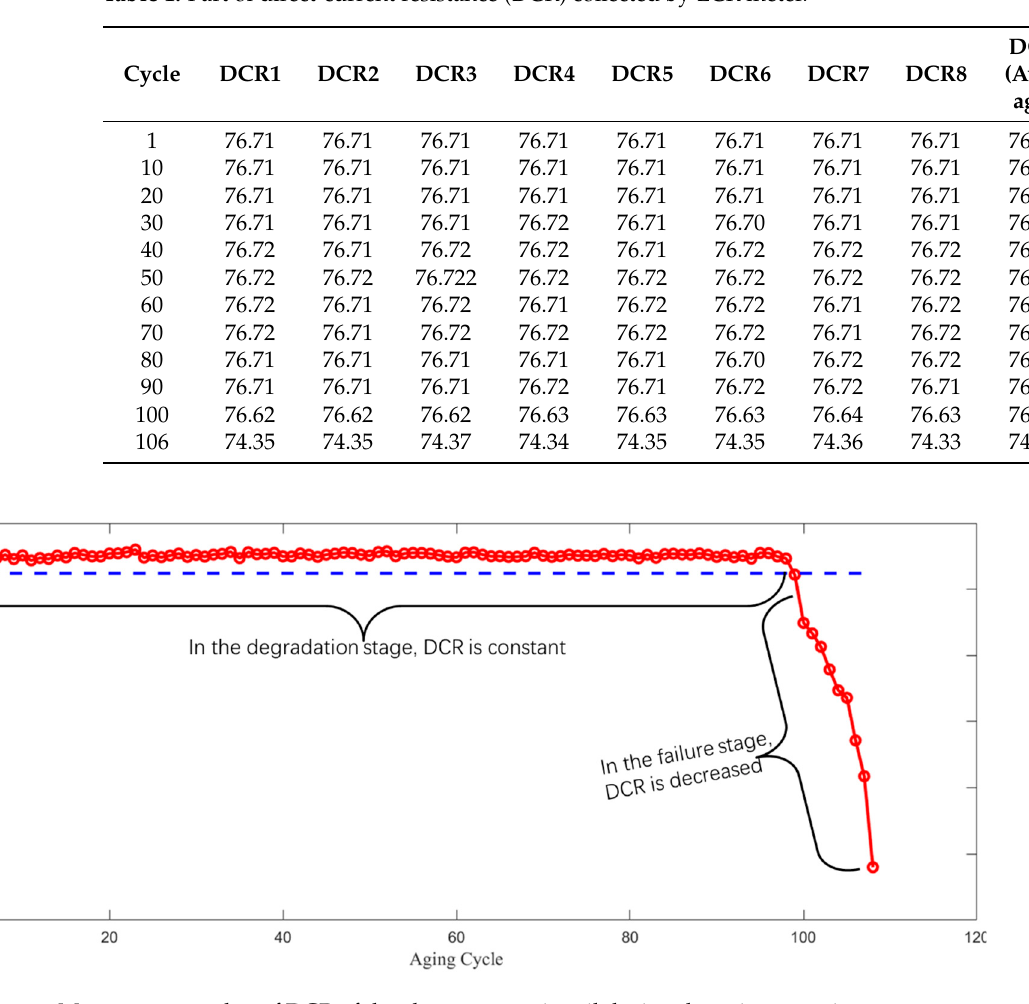
Figure 3. Measurement value of DCR of the electromagnetic coil during the aging experiment.